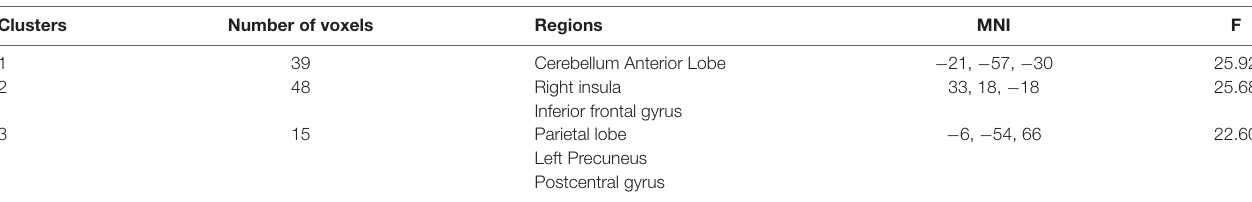
TABLE 2 | Altered dynamic GS topography in AUD patients compared with